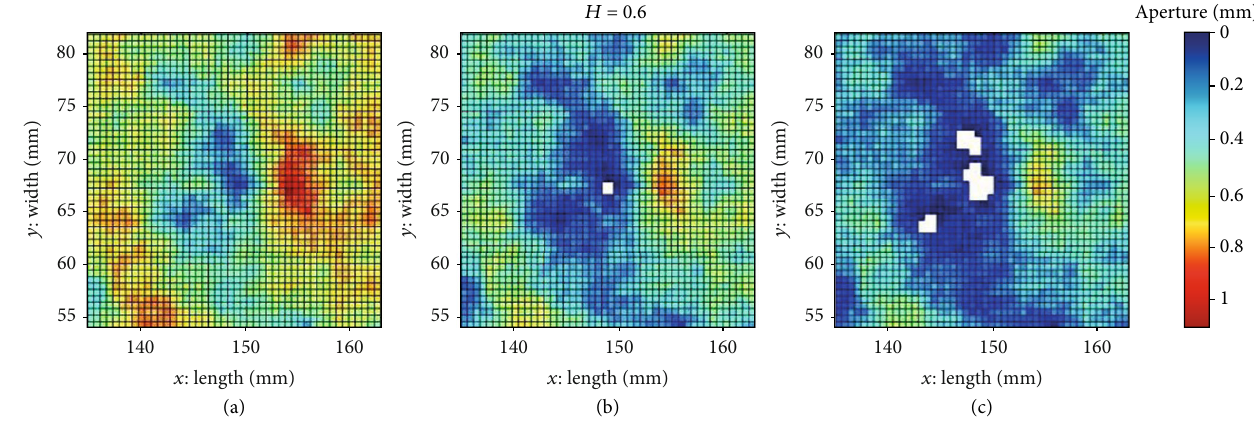
Figure 4: Aperture distribution with H = 0 : 6 : (a) σ